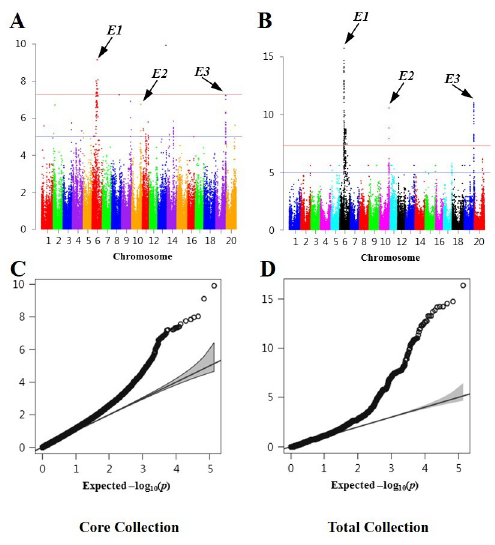
Fig 8. GWAS for days to flowering in the core collection and the total collection. (A) Manhattan plot of the core collection. (B) Manhattan plot of the total collection. (C) Quantile-Quantile plot for days to flowering in the core collection. (D) Quantile-Quantile plot for days to flowering in the total